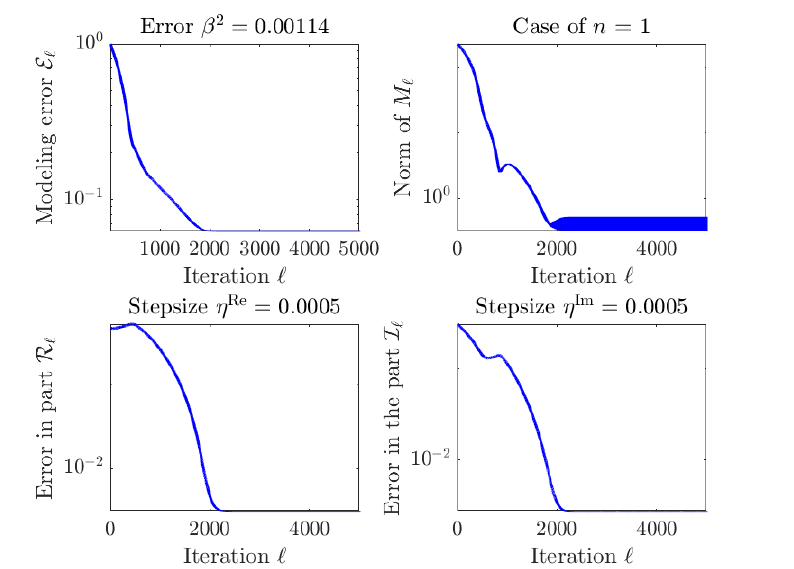
Figure 5. Results of a numerical experiment by the Riemannian-gradient-based geodesic-stepping optimization algorithm in the case that n = 1. (The global modeling error is normalized to its initial value to get rid of the dependence from the random initial